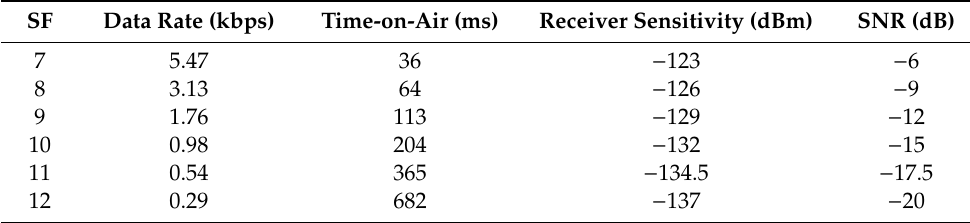
Table 3. Di ff erent SF and the corresponding parameters [74]. Table 3. Different SF and the corresponding parameters [74].